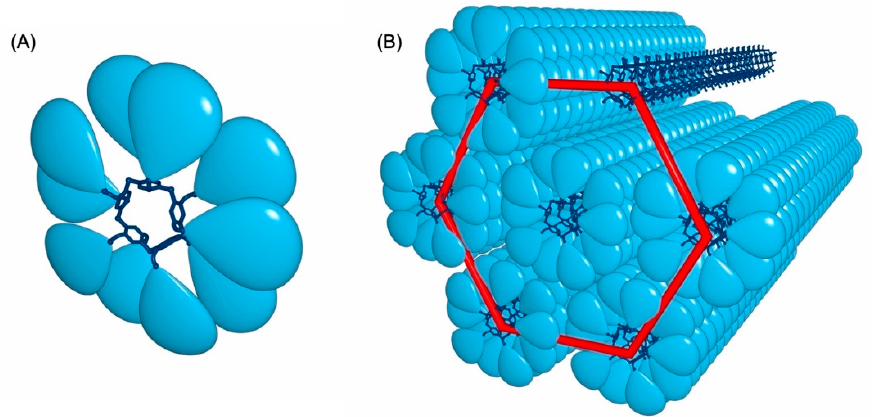
Figure 8. ( A ) Schematic representation of compound 11 . ( B ) Supramolecular arrangement of com- pound 11 into the hexagonal columnar phase, the dendrons have been omitted in one column (top right) to highlight the nanotubular arrangement of the pillar[5]arene cores.